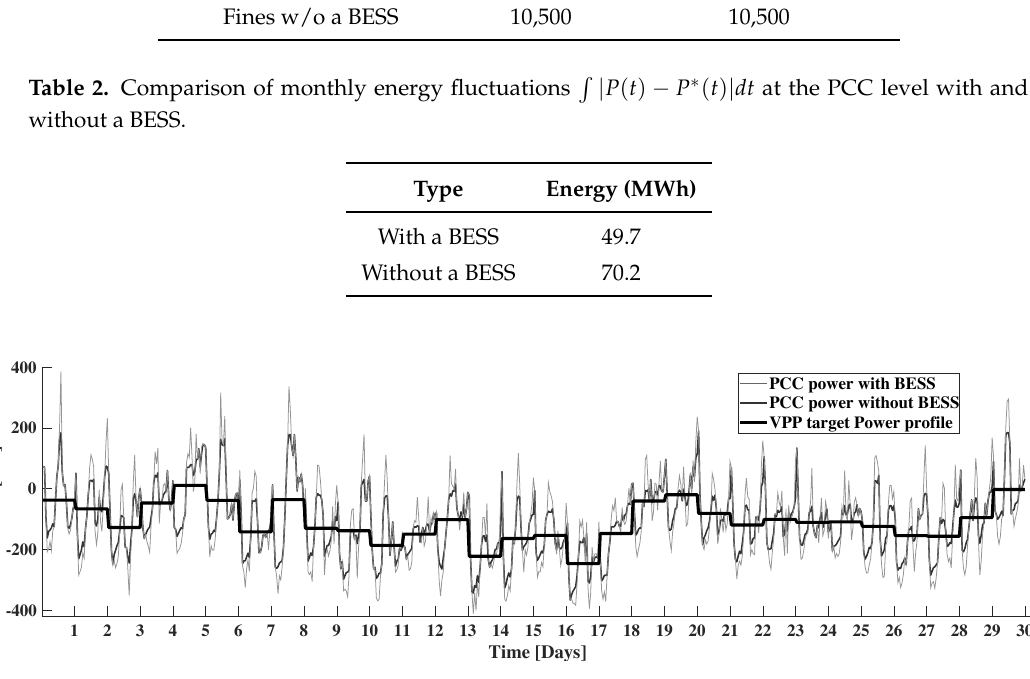
Figure 6. The power profile at the PCC of the considered virtual power plant (VPP), in both presence and absence of a